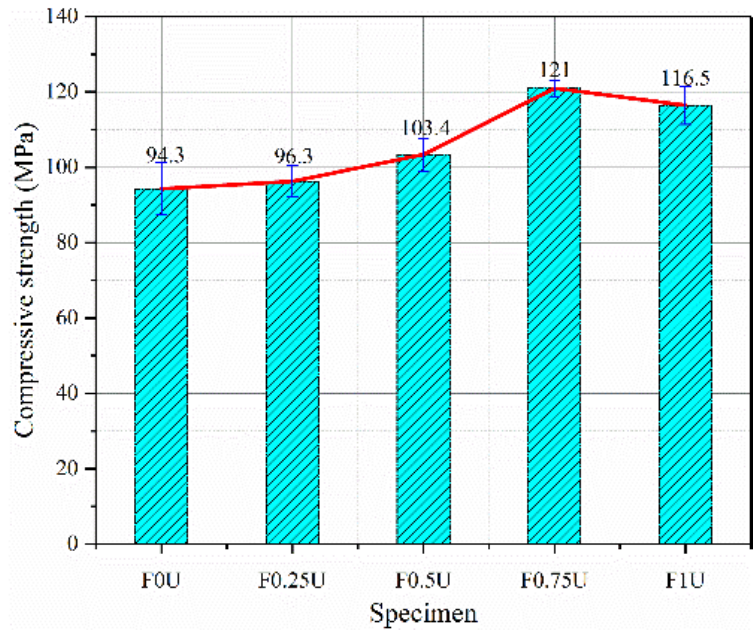
Figure 4. The compressive strength of various bottom layer thicknesses.